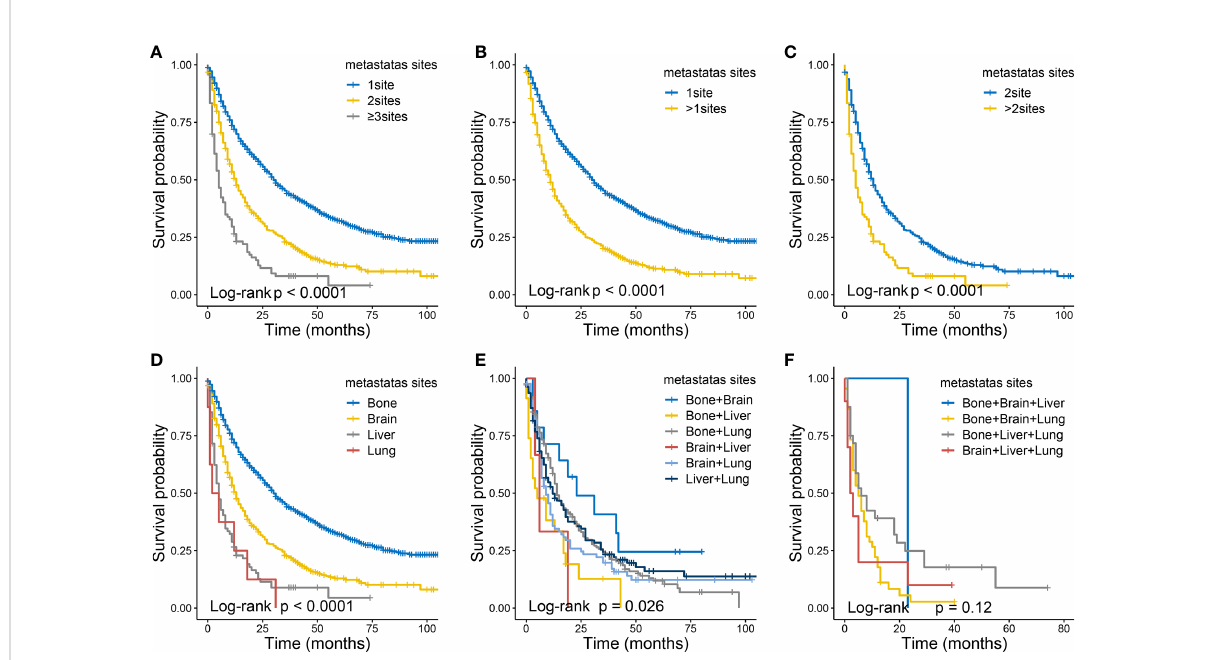
FIGURE 8 The Kaplan-Meier curves of CSS in ccRCC patients according to metastatic status: 1 site versus 2 sites verses ≥ 3 sites (A) , 1 site versus >1 sites (B) , 2 sites versus >2 sites (C) . The Kaplan-Meier curves of CSS in ccRCC patients according to metastatic status: with single site (D) , with two sites (E) , with three sites (F)